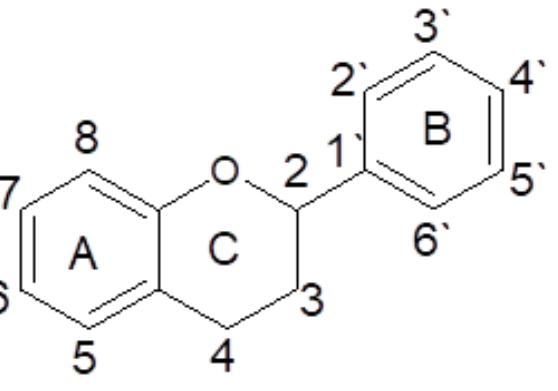
Figure 7. Basic structure and numbering system of flavonoids (own work).